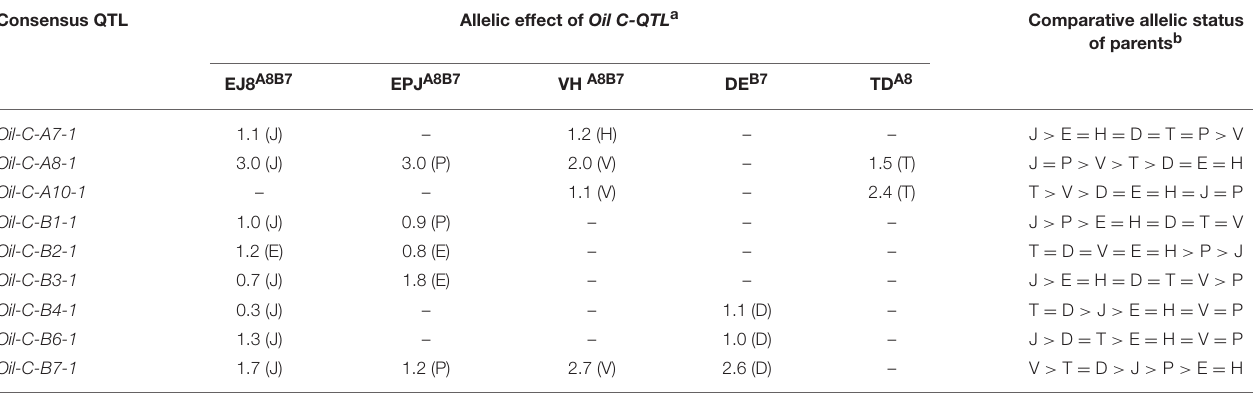
TABLE 5 | Estimation of allelic effects (in percent) of nine Oil C-QTL involving five SE mapping populations and comparative allelic status of the seven parental lines. Consensus